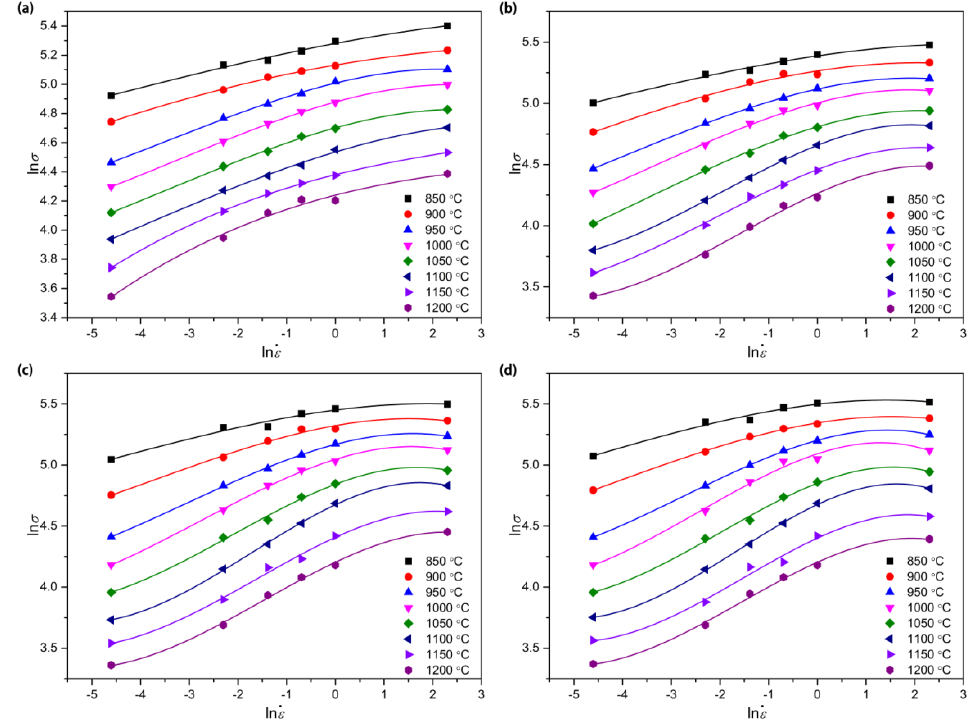
Figure 2. Polynomial fitted curves of ln σ versus 𝑙𝑛ε̇ at strains of ( a ) 0.2; ( b ) 0.4; ( c ) 0.6; and ( d ) 0.7.